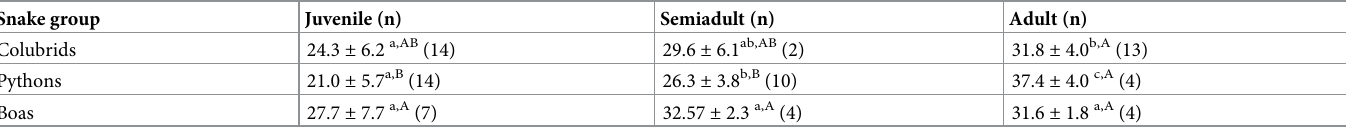
Means in the same line not sharing a superscript small letter differ significantly Means in the same column not sharing a superscript capital letter differ significantly.